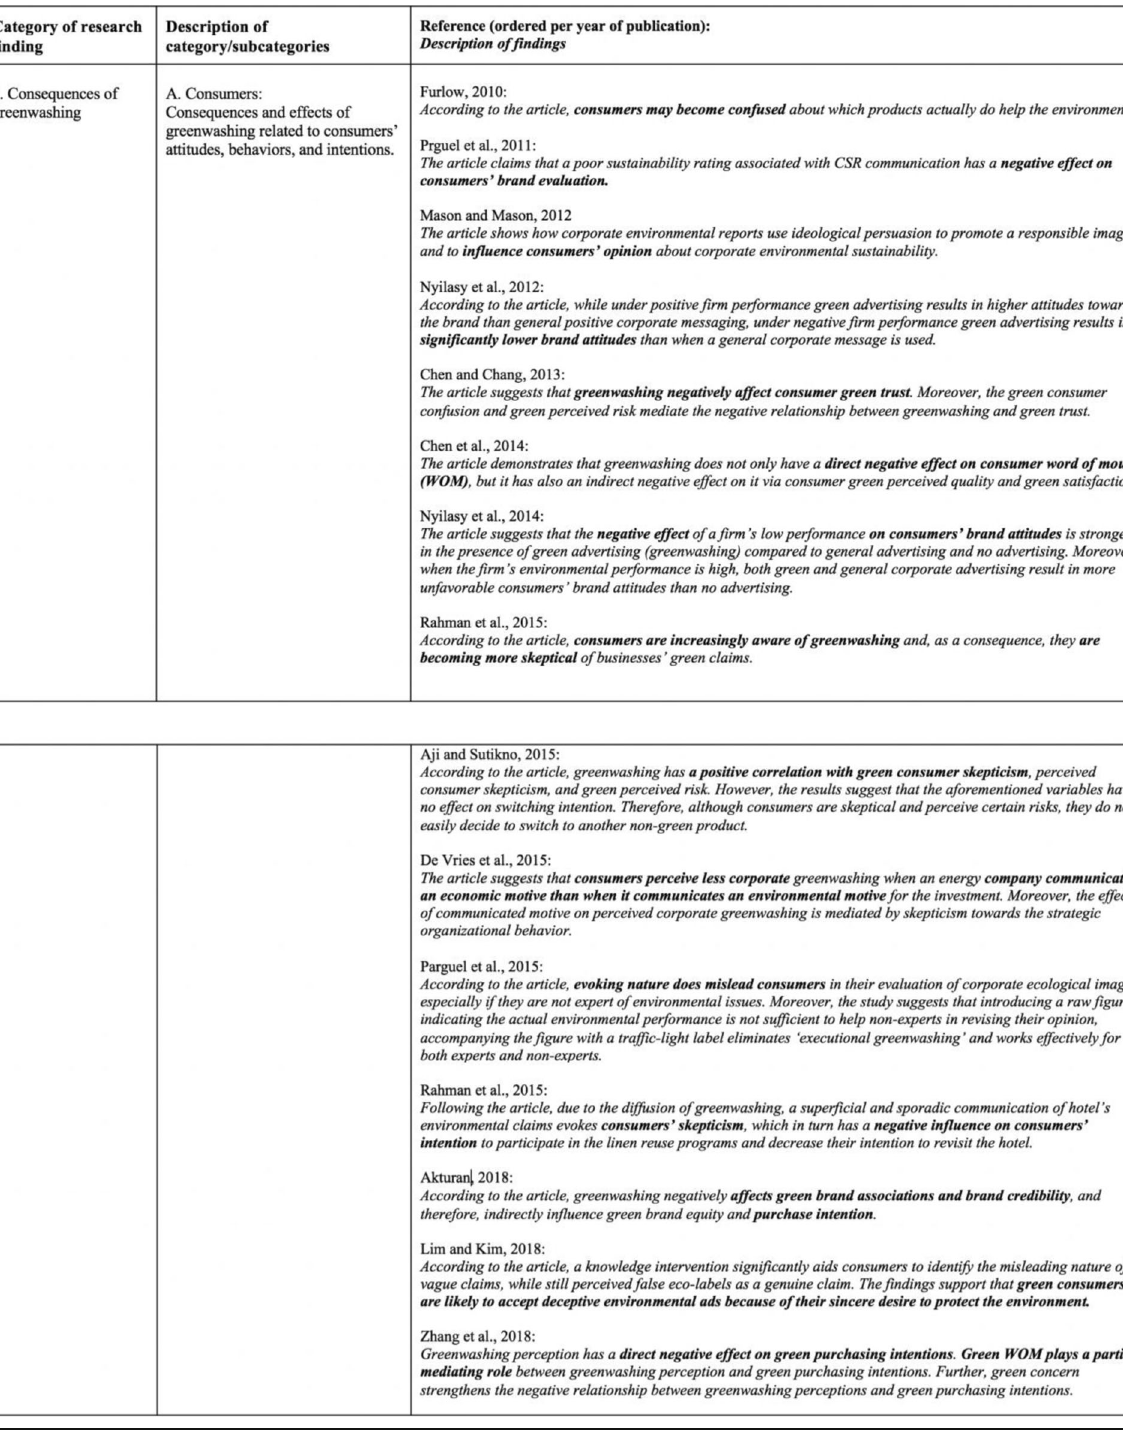
Table 5 Analysis of research findings related to Category